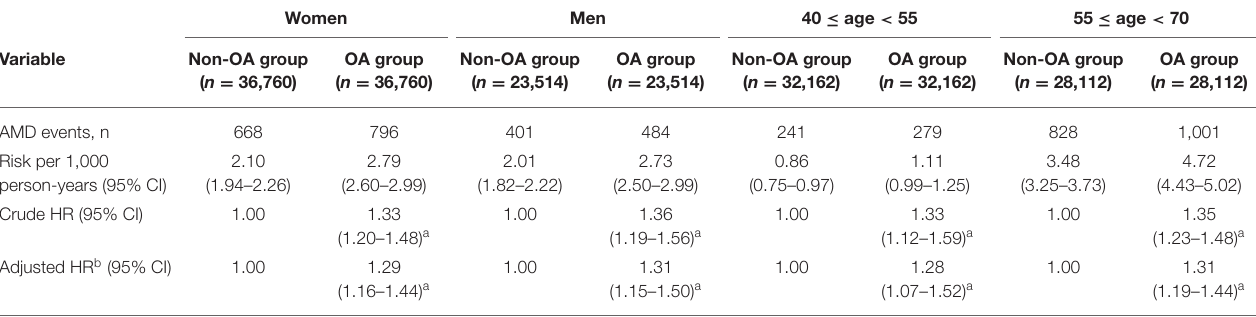
TABLE 3 | Crude and adjusted hazard ratios (HRs) of age-related macular degeneration (AMD) for patients with osteoarthritis (OA), stratified by sex and